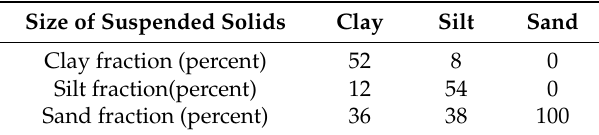
Table 2. The sediment constituents used to create the suspended